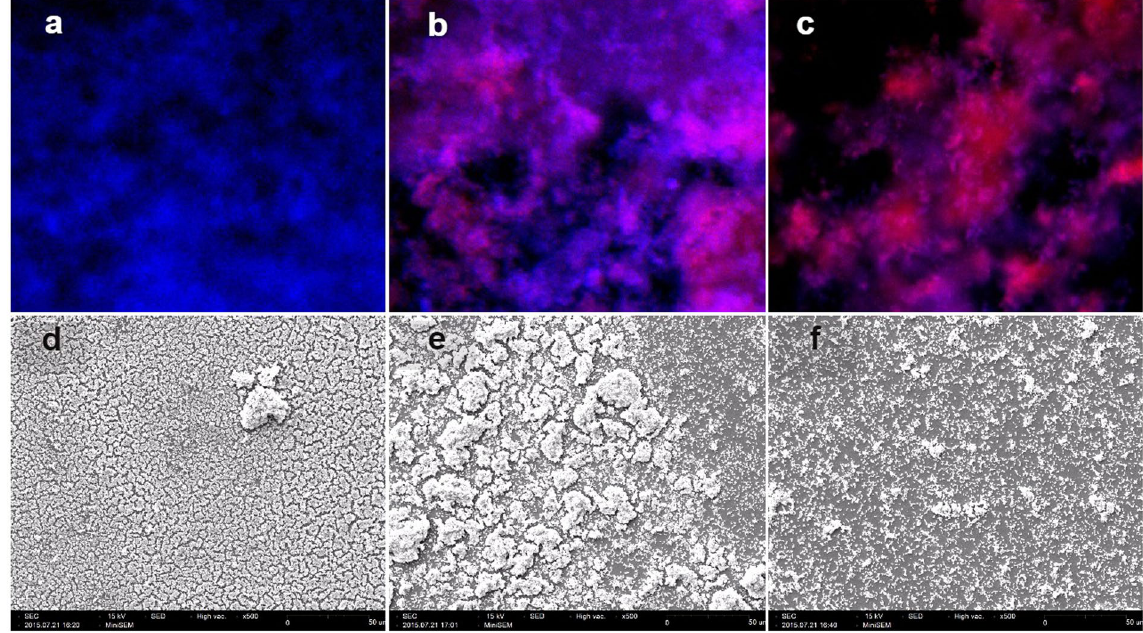
Figure 5. Fluorescence microscopy images of S . aureus SA 113 biofilms treated with PAT using TBO formulations showed that ( a ) control group biofilm treated with PBS had only live bacterial cells. ( b ) Bacterial biofilms treated with PAT using TBO in water had both live (blue) and dead (red) bacterial cells. ( c ) Majority of bacterial cells were dead after treatment with TBO in lipid nanoparticles. Scanning electron microscopy images (at 500X magnification) of S . aureus SA 113 biofilms treated with PAT using TBO formulations ( d ) Control group had dense and continuous biofilm structure. ( e ) Biofilms treated with PAT using TBO in water had some fragmentation. ( f ) Biofilms treated with PAT using TBO in lipid nanoparticles were intensely fragmented and damaged, and also reduced in